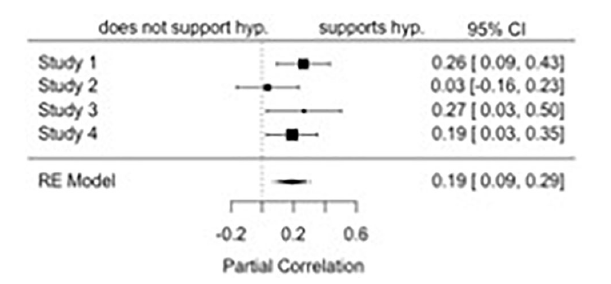
FIGURE 3 | A forest plot of the meta-analyzed two-way interaction between attitude and attitude strength on affective attraction. replicated two previously established findings: that similarity breeds attraction and that attitude strength-related properties moderate this relation (e.g., Montoya and Horton, 2013; Sawicki and Wegener, 2018; Wallace et al.,